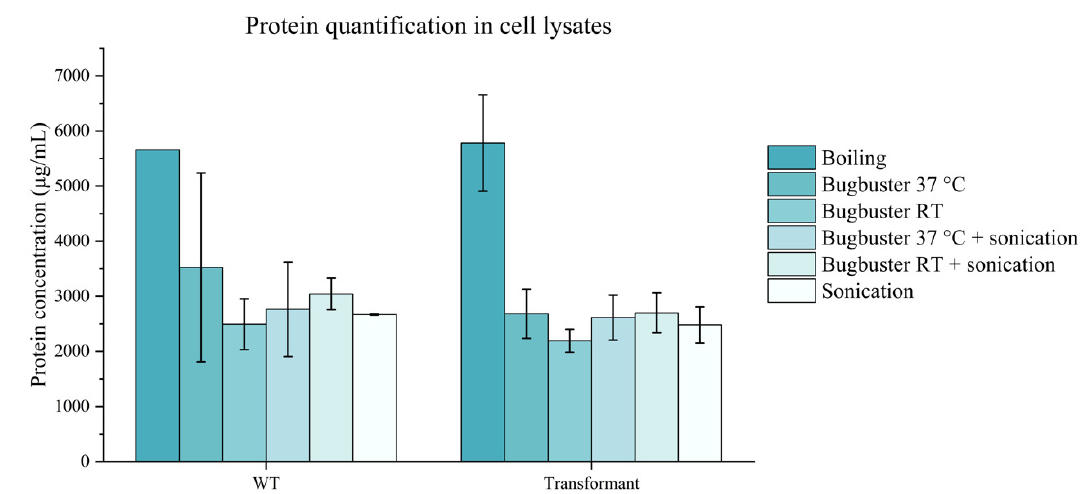
Figure 5. Total protein concentration in cell lysate samples, quantified by the BCA assay. Different lysis methods were investigated on wild-type (WT) cells and transformant cells to exclude that the plasmid was impacting lysis efficiency. Error bars represent standard deviation ( n = 3). RT = room temperature.